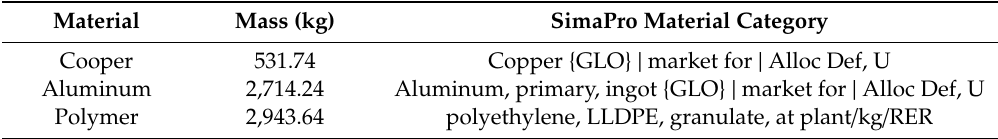
Table 2. Wiring of V112